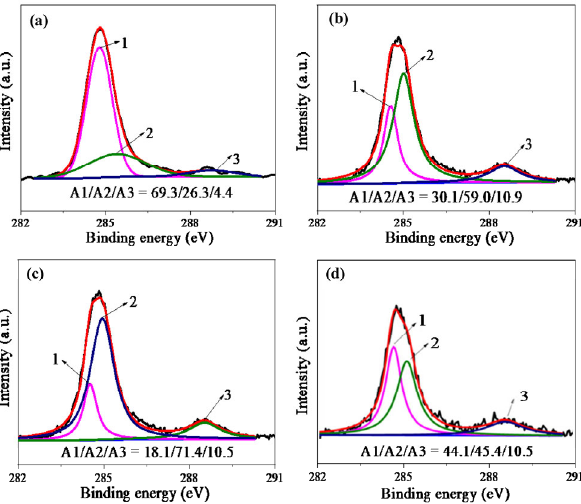
Fig. 14 XPS spectra of the rubbed surfaces lubricated by PAO6 containing or without different mass concentrations of TiO 2 /BP nanocomposites under the load of 20 N: (a) Survey, (b) Fe 2p, (c) Fe 2p at 0%, and (d) Fe 2p at 0.01%.